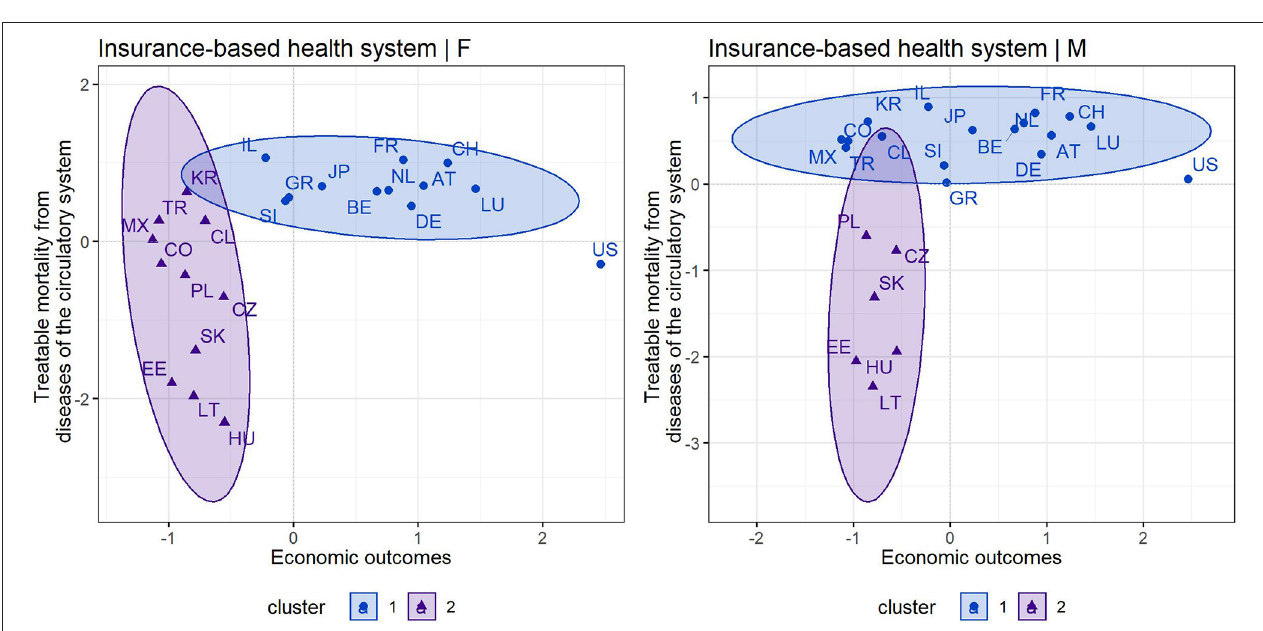
gender categories in countries with an insurance-based health system. The preference for this variant of the panel regression model was based on the results of F tests indicating significant effects in the data structure only within countries and on the results of the Hausman test with a p > 0.05 recommending a